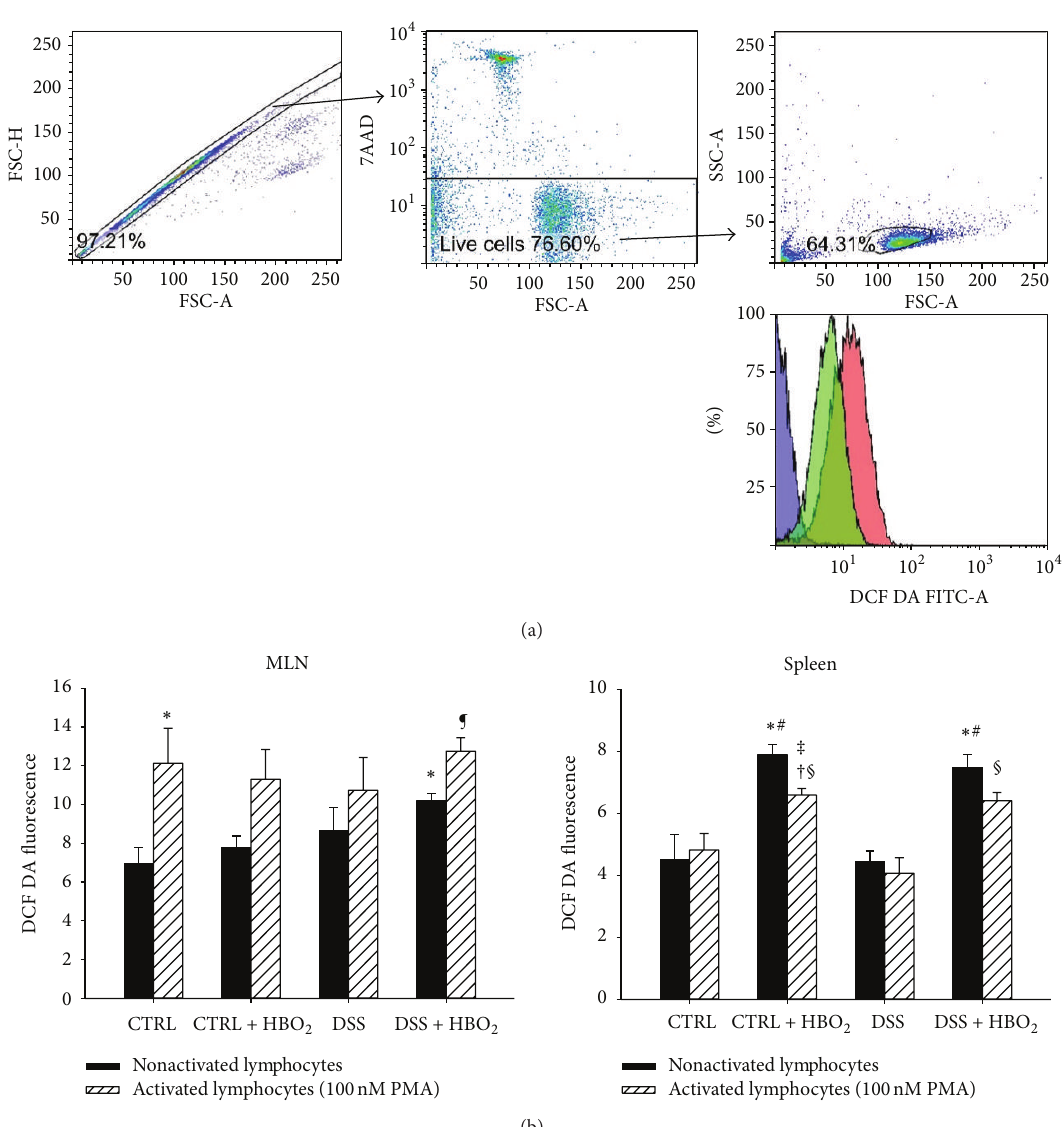
Figure 6: Lymphocyte H 2 O 2 and ONOO − production during colitis and HBO 2 treatment. BALB/c mice at the age of 10–12 weeks were randomly assigned into 4 groups ( 𝑛 = min. 4 mice/group/experiment): CTRL: control mice, CTRL + HBO 2 : control mice undergoing HBO 2 (60min/2.4 ATM, 2x/day, days 1–8), DSS: mice receiving dextran sodium sulphate (DSS, 5%w/v, days 1–7), and DSS + HBO 2 : DSS treated mice undergoing HBO 2 . To assess the basal intracellular H 2 O 2 and ONOO − levels, lymphocytes isolated from MLN and spleens were stained with 10 𝜇 M DCF DA and analysed by flow cytometry (black bars, (b)). Next, lymphocytes were activated with 100nM PMA for 30min and the ROS production measurement repeated (lined white bars, (b)). (a) shows a representative lymphocyte gating strategy panel and a histogram of DCF-DA signal from the negative control (blue), resting lymphocytes (green), and the PMA activated lymphocytes (red). Doublets were excluded by forward scatter area (FSC-A) versus forward scatter height (FSC-H) and the dead cells by 7-AAD staining. Data are presented as mean ± s.e.m.; ∗ statistically different compared to CTRL, 𝑃 < 0.05 ; # statistically different compared to DSS group, 𝑃 < 0.05 ; † statistically different from CTRL + HBO 2 , 𝑃 < 0.05 ; ‡ statistically different compared to activated lymphocytes of CTRL group, 𝑃 < 0.05 ; § statistically different from the activated lymphocytes of DSS group, 𝑃 < 0.05 . DCF DA: dichlorofluorescein diacetate; PMA: phorbol myristate acetate; 7-AAD: 7-aminoactinomycin D; ¶ statistically different from nonactivated lymphocytes DSS + HBO 2